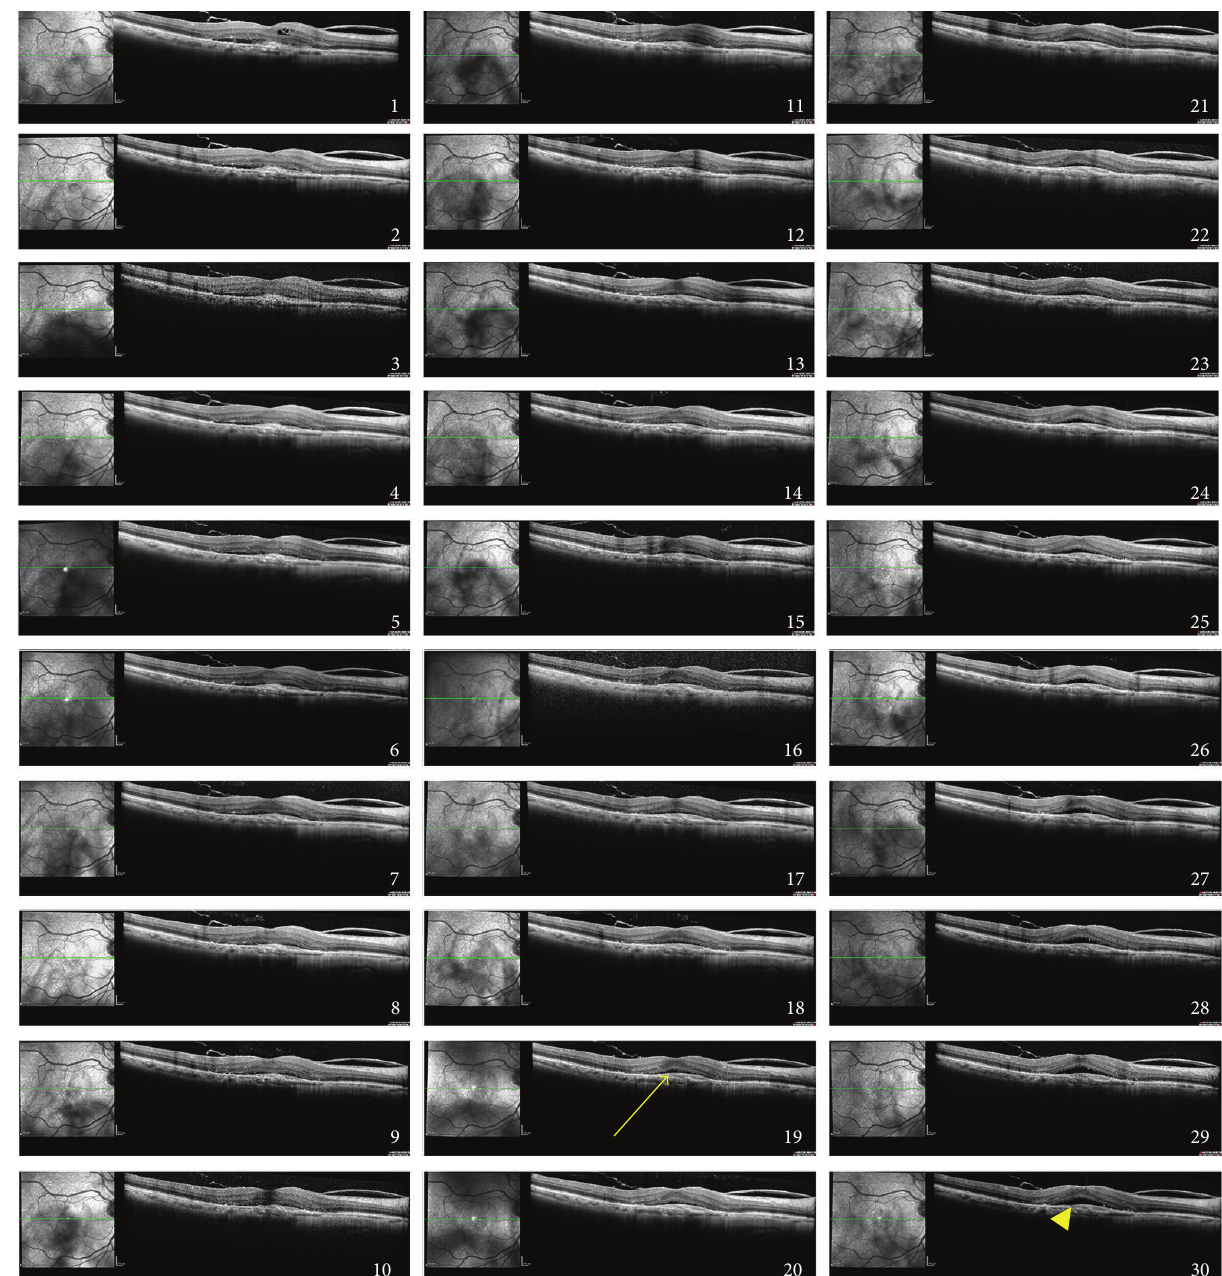
Figure 3: Daily cross-sectional one-line optical coherence tomography (OCT) B-scans over a 30-day period of patient 4. Immediately posttreatment decrease of central retinal thickness with rebound increase of subretinal fluid during follow-up, starting at day 18. On day 30, it is possible to identify the recurrent SRF (yellow